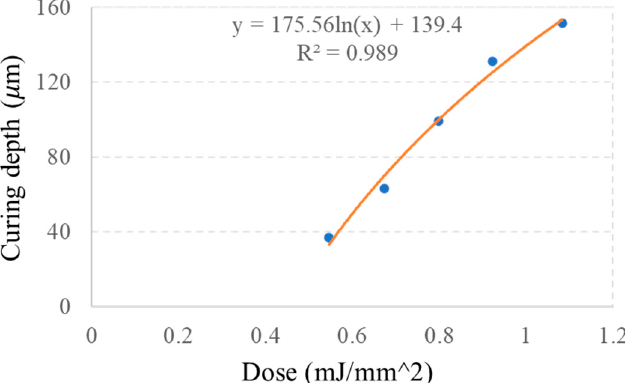
Figure 2. Curing depth of photosensitive resin as a function of UV energy flux.